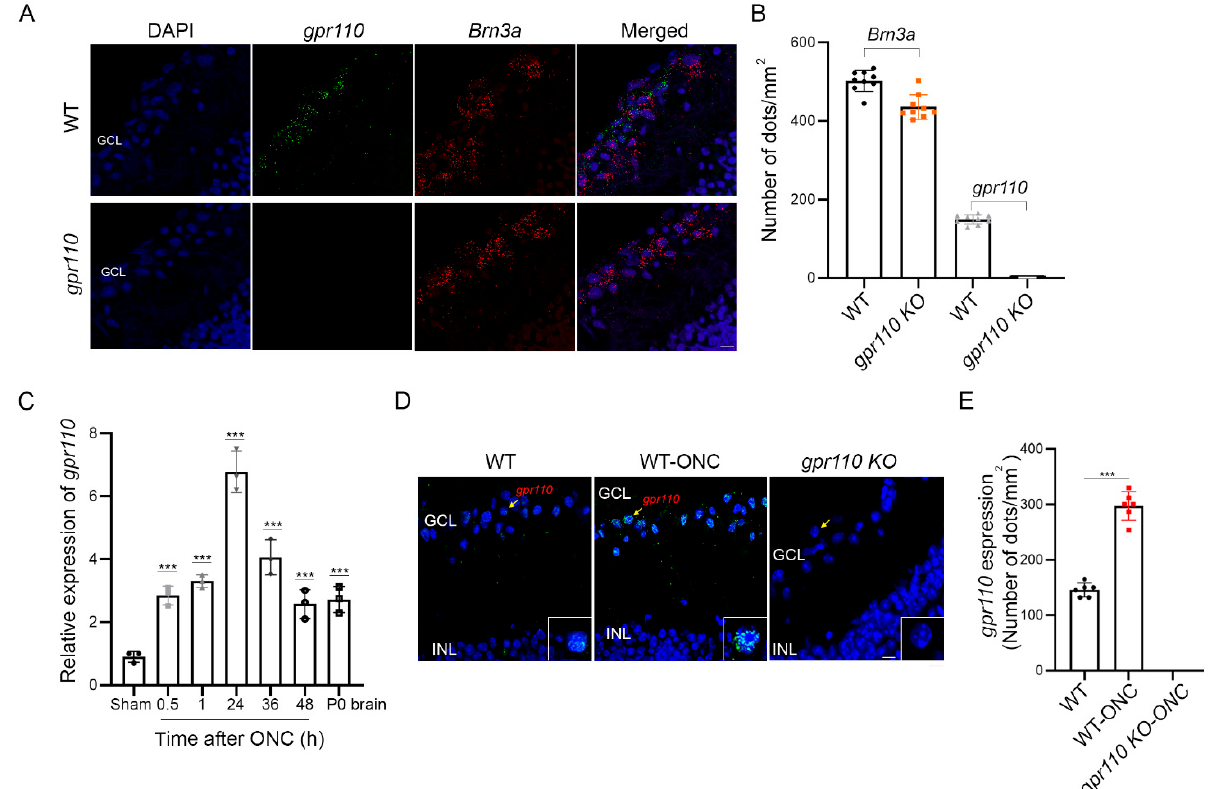
Figure 4. Optic nerve injury upregulates gpr110 expression. ( A ) Expression of gpr110 in RGCs from 4-month-old mice detected by in situ hybridization using probes for gpr110 (green) and a RGC marker Brn3a (red), overlaid on DAPI-stained nuclei (blue). ( B ) Quantitation of gpr110 expression. ( C – E ) Induction of gpr110 in the retina tissue after ONC determined by qRT-PCR ( C ) and by in situ hybridization of the ganglion cell layer (GCL) with micrographic ( D ) and quantitative results ( E ). Data are expressed as mean ± s.e.m with n = 9 ( B ) n = 3 ( C ) and n = 6 ( E ) per group. *** p < 0.001 by one-way ANOVA. GCL, ganglion cell layer; INL, inner nuclear layer. Scale bars, 20 µm ( A , D ).